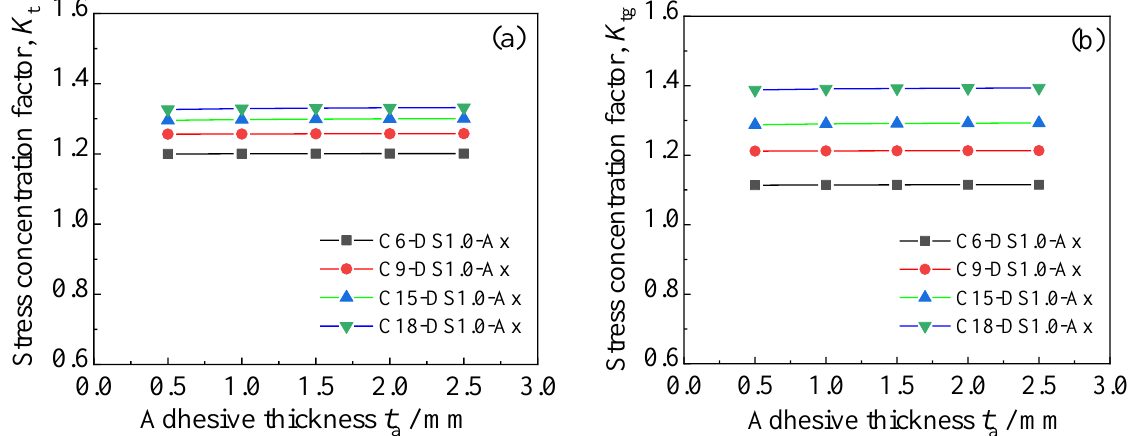
Figure 18. Effect of adhesive thickness on the stress concentration factors ( a ) K t and ( b ) K tg of the corroded steel plates strengthened with CFRP plates.